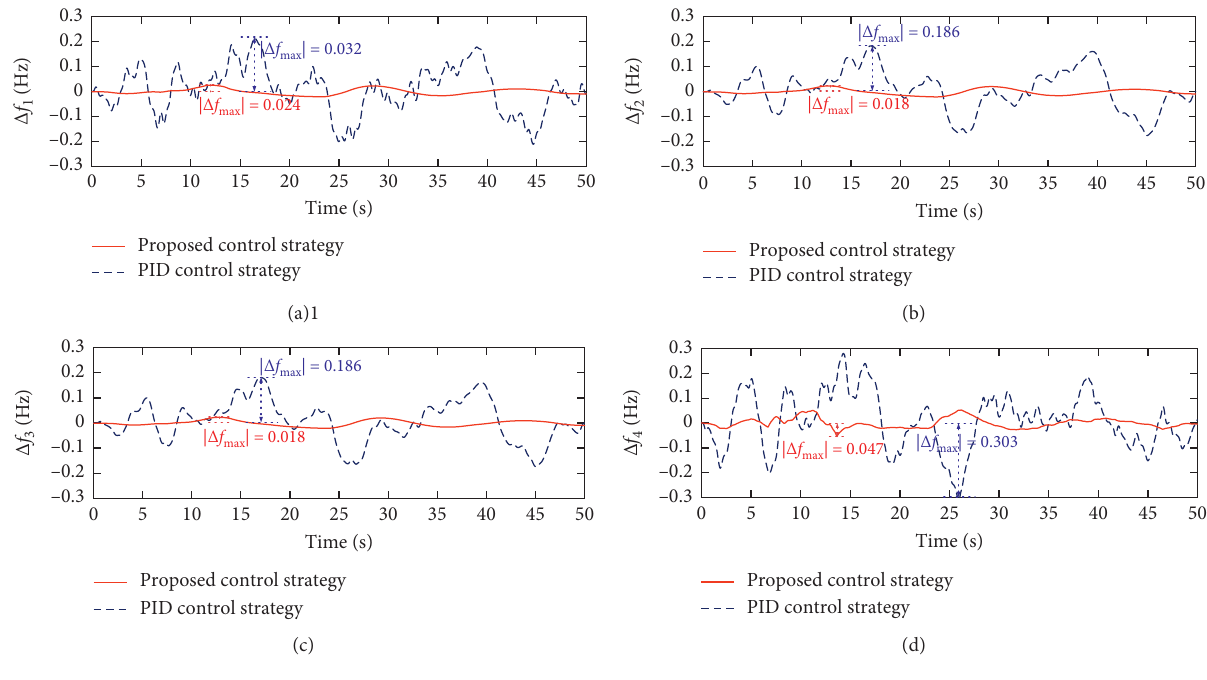
Figure 9: Frequency deviation of four